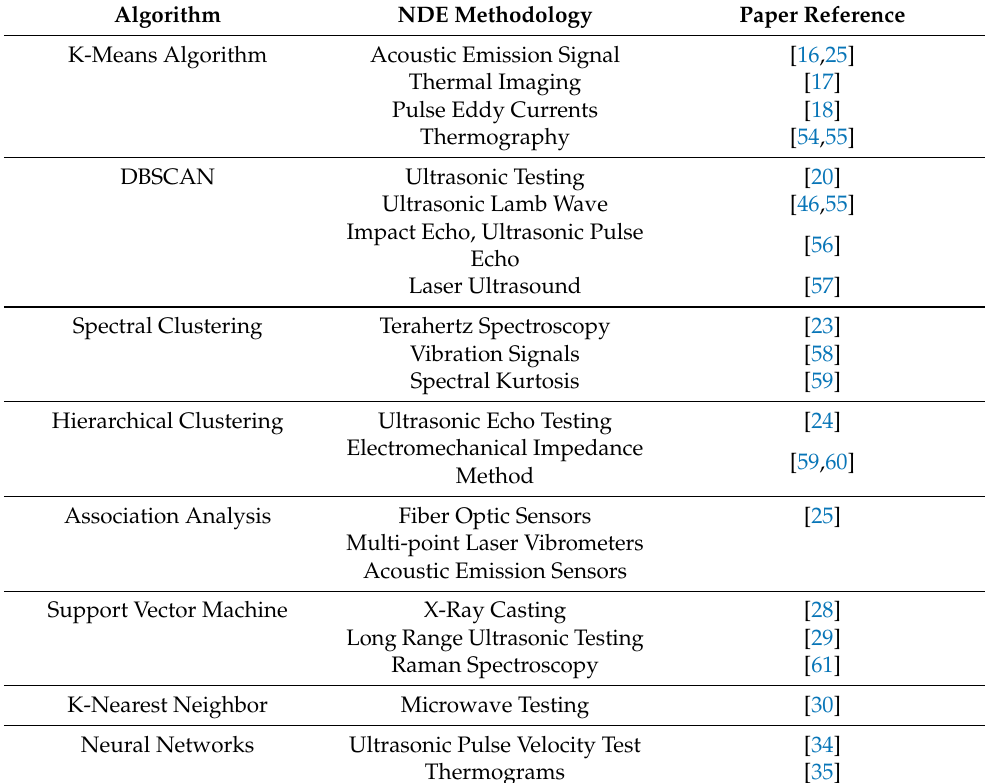
Table 1. Machine Learning Algorithms with